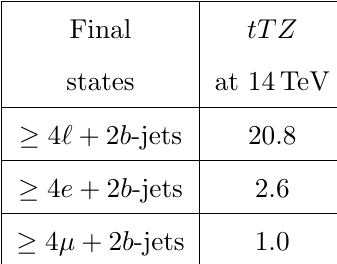
and ~ t 1 ~ t (cid:3) respectively. 1 1